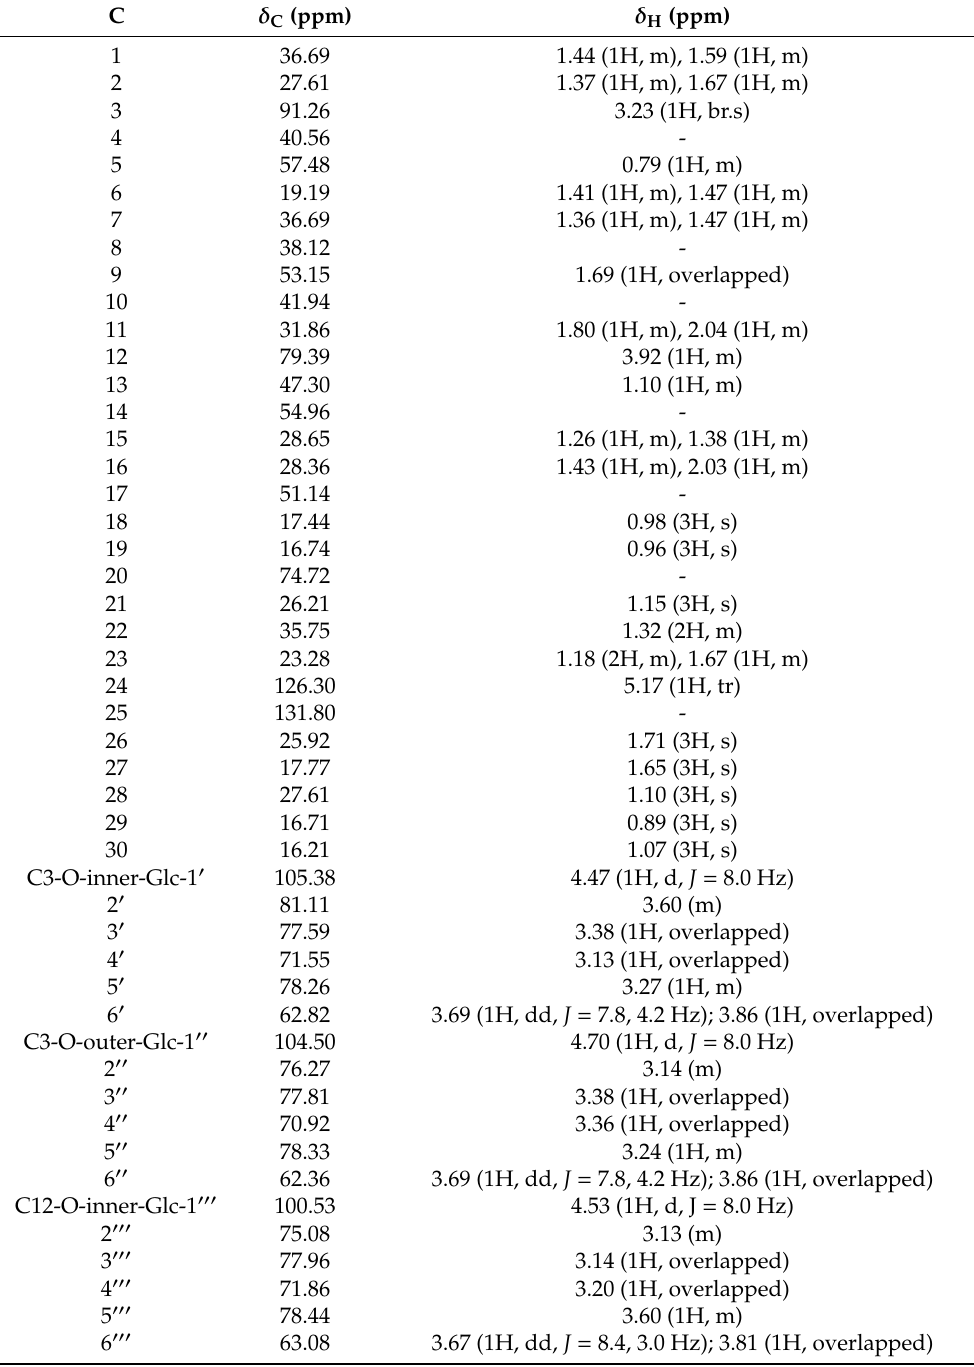
Table 1. 1 H- and 13 C-NMR spectral of unnatural ginsenoside Rd12 (methanol- d 4 , 600